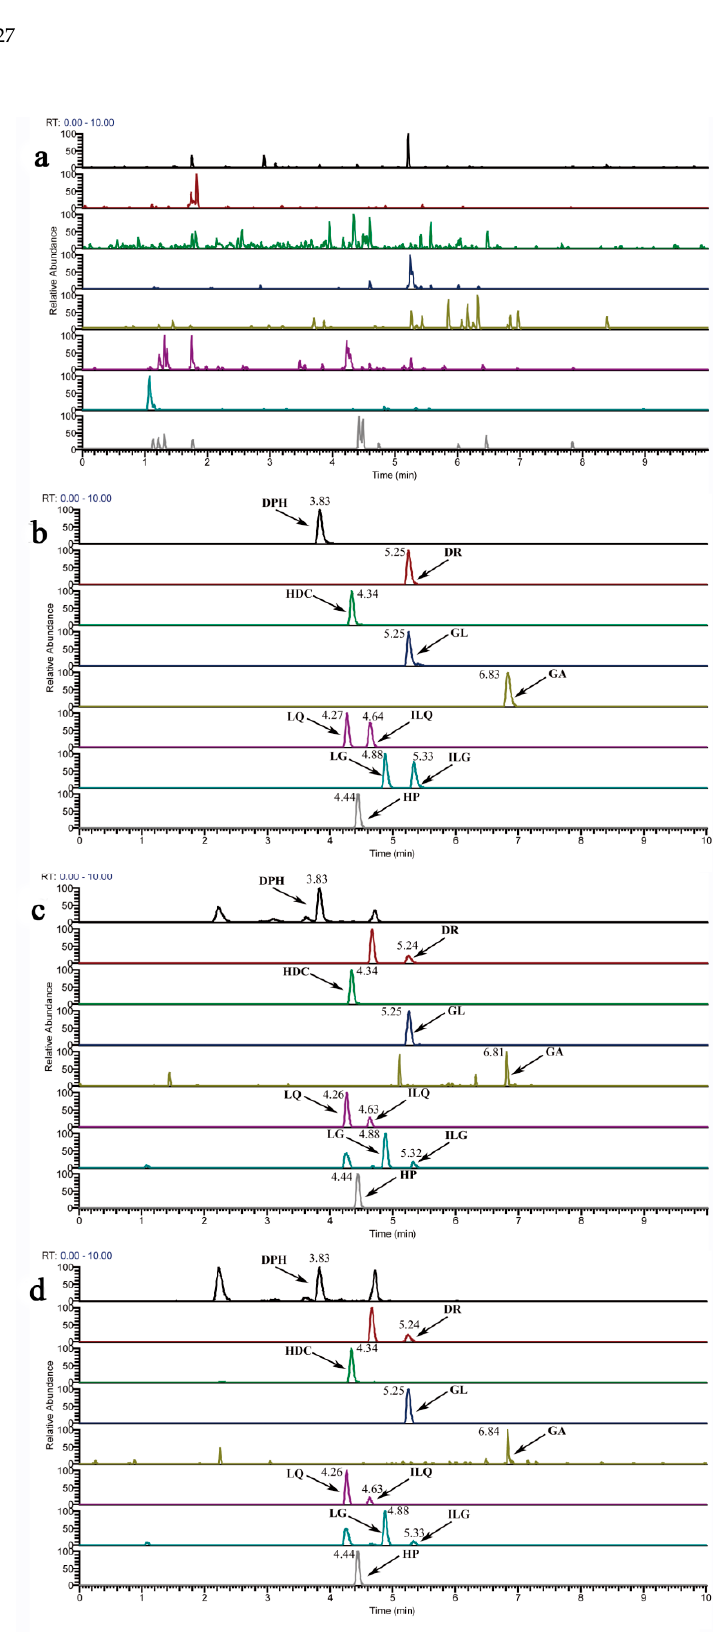
Figure 1. The selective reaction monitor (SRM) chromatograms of analytes in blank plasma samples ( a ); blank plasma samples spiked with mixed standards and IS ( b ); plasma samples obtained from normal rats ( c ); and plasma samples obtained from AA model rats ( d ). Abbreviation notes: DPH: daphnetin; DR: daphnoretin; HDC: 7-hydroxycoumarin; LQ: liquiritin; LG: liquiritigenin; ILQ: isoliquiritin; ILG: isoliquiritigenin; GL: glycyrrhizin; GA: glycyrrhetinic acid.